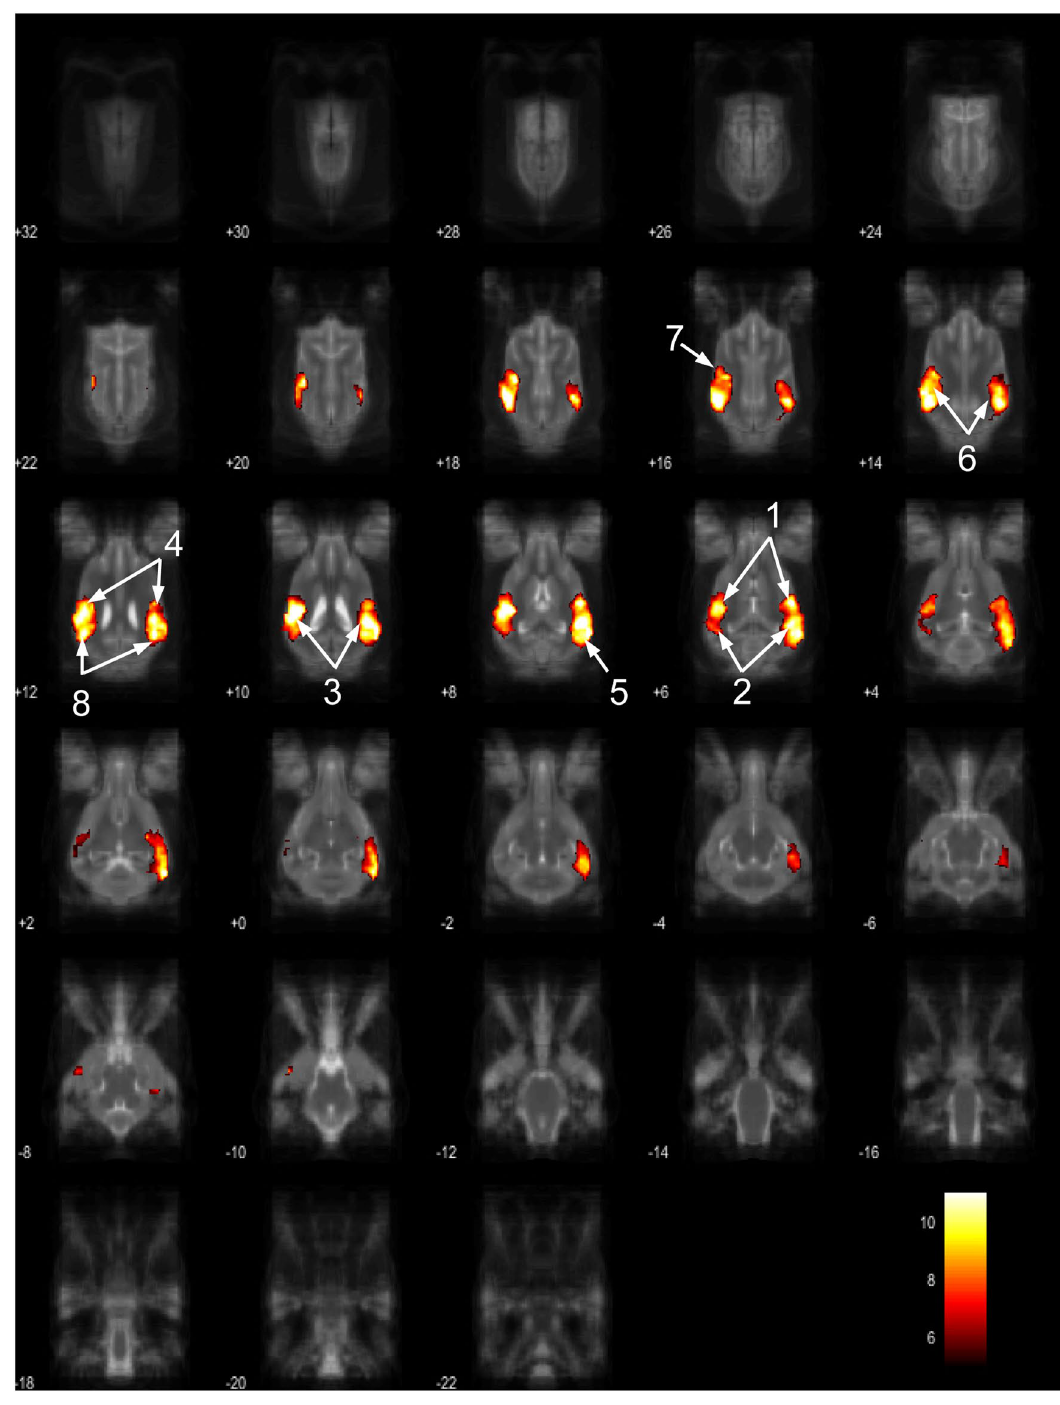
Figure 12. Resting-state network component I from the 15 component gICA. We report the results with a voxel-wise FDR corrected p < 0.001 and cluster treshold of FDR corrected p < 0.005. gICA components are presented as thresholded T-maps, corrected for multiple comparisons, overlaid on the Nitzsche atlas 15 . 1. rostral sylvian gyrus, 2. caudal sylvian gyrus, 3. middle ectosylvian gyrus, 4. rostral ectosylvian gyrus, 5. caudal ectosylvian gyrus, 6 middle suprasylvian gyrus, 7. rostral suprasylvian gyrus, 8. caudal suprasylvian